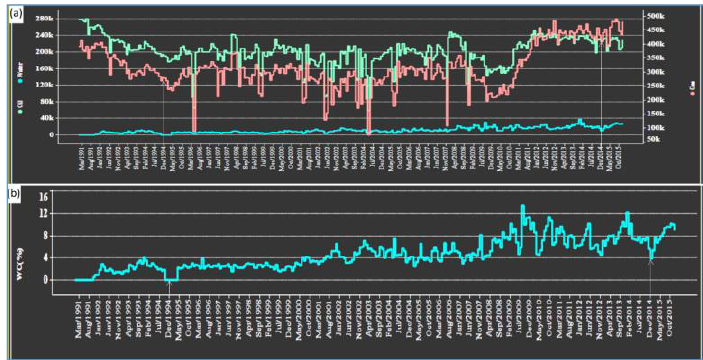
Figure 10. Reservoir performance over time. ( a ) Water injection, ( b ) gas injection. The white arrow shows the 4D time-lapse between the base year 1994 and the monitoring year 2014, showing a de-